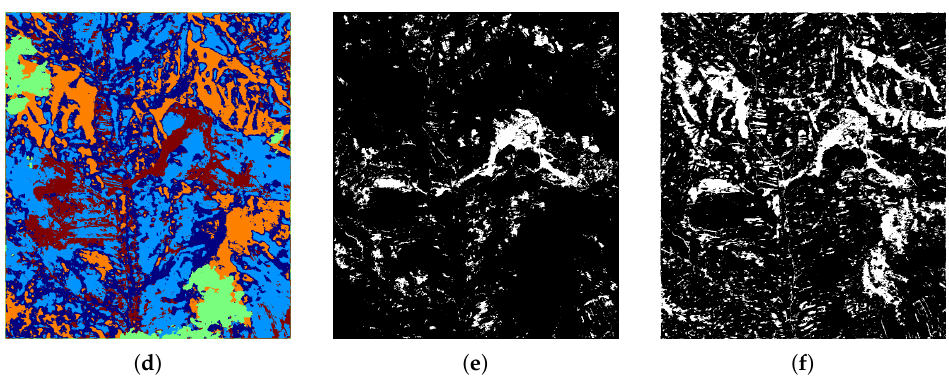
Figure 10. Anomaly detection in SITS—landslide use-case scenario. From left to right: ( a ) matrix of d max values, ( b ) anomaly identification using the EM-based approach, ( c ) ground truth, ( d ) DTW- based clustering of heterogeneous SITS using the approach proposed in Ref. [5], ( e ) retrieval of similar evolution patterns in heterogeneous SITS using DTW-EM described in Ref. [36], and ( f ) change map using ACE-Net presented in Ref. [10]. Table 2. Performance evaluation and comparisons with other